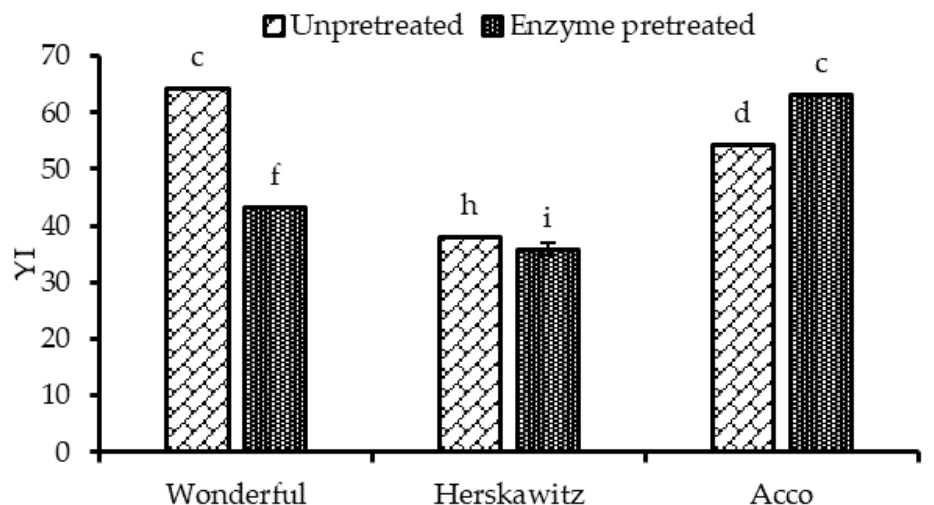
Figure 3. The yellowness index (YI) of un-pretreated and enzyme pretreated seeds (1.7%, 40 °C, pH = 4.5 and 5 h) from studied pomegranate cultivars. Within the same cultivar (un-pretreated and enzyme pretreated), columns followed by different letters are significantly different ( p < 0.05), according to Duncan’s multiple range test. Vertical bars indicate the standard deviation of the mean.